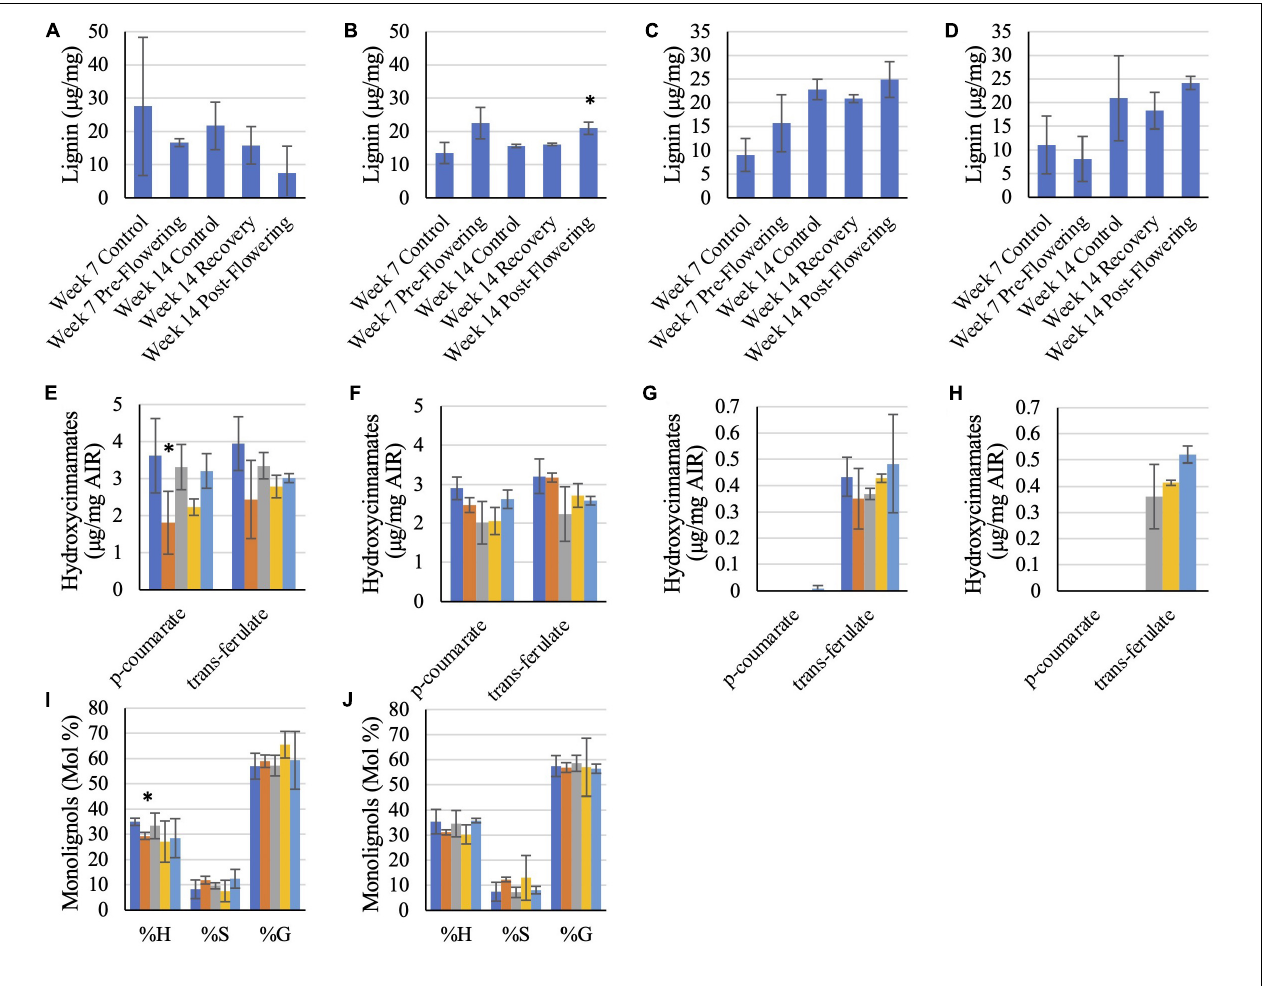
FIGURE 4 | Lignin analysis of RTx430 (A,C,E,G,I) and BTx642 (B,D,F,H,J) leaves and roots. Released lignin from acetyl bromide treatment of leaves (A,B) and roots (C,D) . Data represents mean ± SD of three biological replicates per condition per genotype where biological replicates themselves consist of 10 pooled plants from the same planting block. Some replicates have been removed in this analysis, leaving two biological replicates rather than three, due to being extreme outliers. Monolignol relative composition of leaves (E,F) and roots (G,H) . Data represents mean ± SD of three biological replicates per condition per genotype where biological replicates themselves consist of ten pooled plants from the same planting block. Hydroxycinnamate content of leaf samples (I,J) , where data represents mean ± SD of three biological replicates per condition per genotype where biological replicates themselves consist of ten pooled plants from the same planting block. Several replicates had to be removed from the root samples (samples in which both p -coumarate and trans -ferulate were below the limit of detection). Standard deviation error bars, with data points without error bars representing points in which only one sample had detectable data. Asterisks indicate p < 0.05 from Student’s t -tests with the Benjamini–Hochman